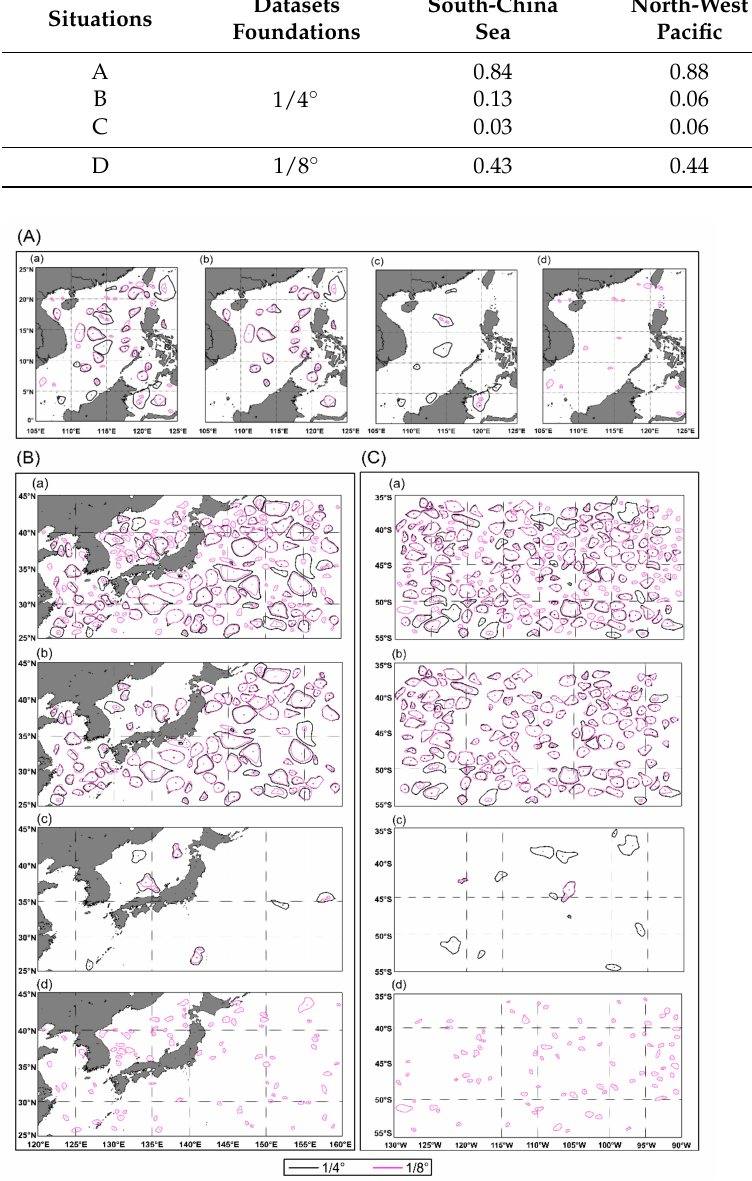
Figure 10. Visualization of eddies for four matching situations of two resolution eddies in the three regions: ( A ) the South-China Sea; ( B ) the North-West Pacific; ( C ) the South-West Pacific. The black lines represent eddy effect contours identified by 1/4 ◦ data, and the magenta lines represent eddy effect contours identified using the 1/8 ◦ data. ( a ) represents all eddies identified using the 1/4 ◦ and 1/8 ◦ all-sat products, ( b ) represents Situation A, ( c ) represents Situation B and C, and ( d ) represents Situation